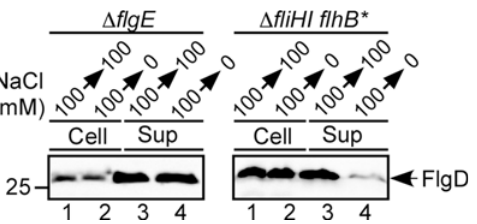
Fig 2. Effect of Na + depletion on flagellar protein export. The level of FlgD export is shown for the wild- type export apparatus ( Δ flgE in the left panel) and for the Δ fliH-fliI flhB(P28T) bypass mutant cells (right panel). The NME001 ( Δ flgE ) and MMHI0117 ( Δ fliHI flhB * ) cells were grown exponentially at 30°C in T-broth containing 100 mM NaCl at an external pH of 7.5. After washing twice with T-broth (pH 7.5) without 100 mM NaCl, the cells were resuspended in T-broth (pH 7.5) with or without 100 mM NaCl and incubated at 30°C for 1 hour. The whole cell (Cells) and culture supernatant fractions (Sup) were analyzed by immunoblotting with polyclonal anti-FlgD